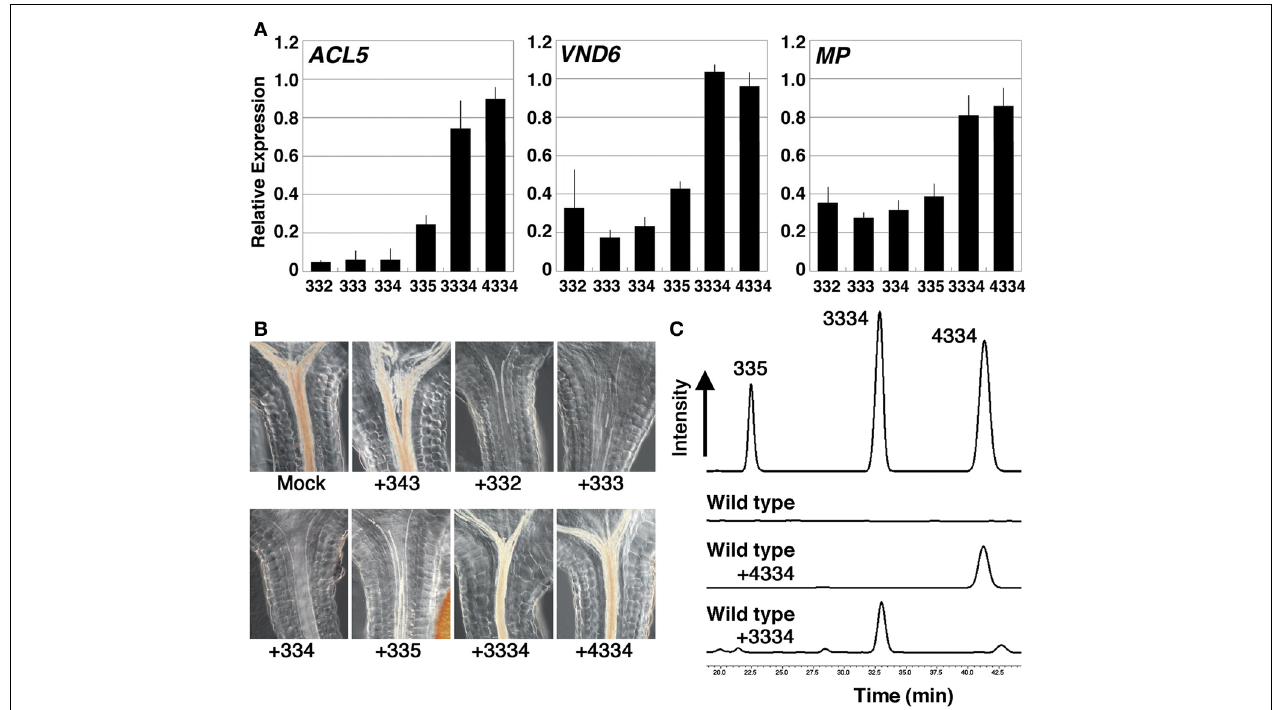
FIGURE 5 | Effect of polyamines in the acl5-1 spms-1 double mutant. (A) Effect of polyamines on the expression of ACL5 , VND6 , and MP . Total RNA was prepared from acl5-1 spms-1 seedlings grown for 7 days in MS solutions and treated for 24h in MS plus 100 µ M each polyamine. Numbers correspond to those of the carbon shown in Table 1 . All transcript levels are relative to those in mock-treated acl5-1 spms-1 seedlings. Error bars represent the SE ( n = 3). (B) Effect of polyamines on xylem development. acl5-1 spms-1